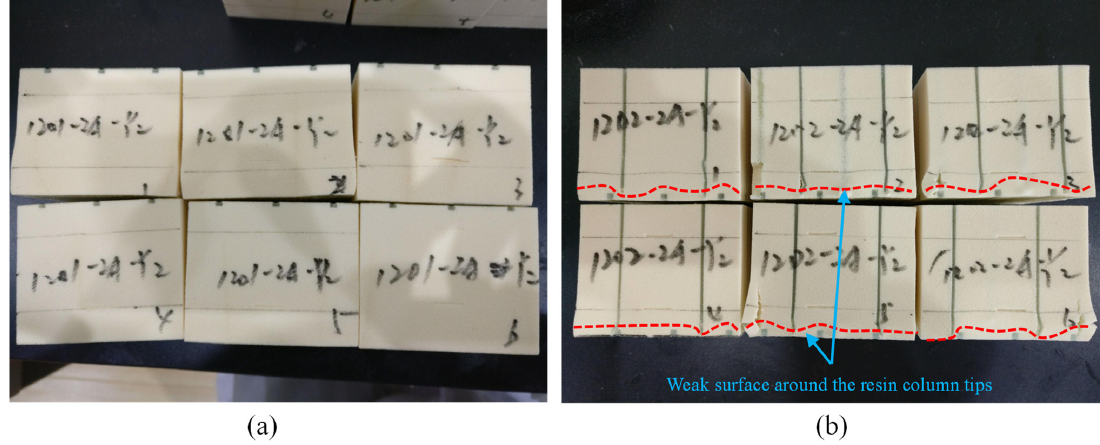
Figure 6. Failure modes of the compressive specimens: ( a ) GP core and ( b ) GPC core.